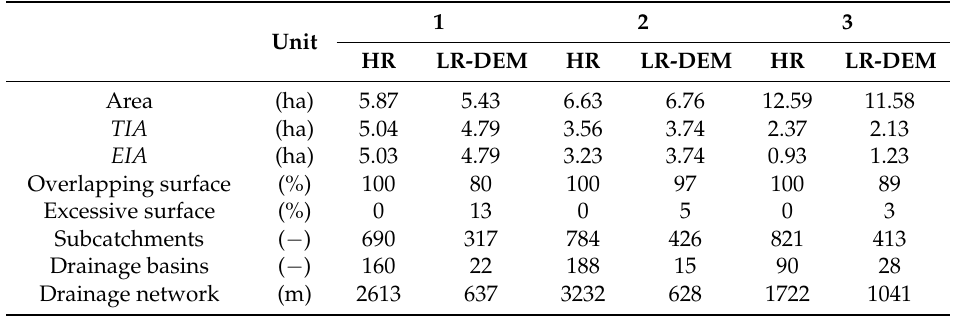
Table 5. Catchment properties of the HR and LR-DEM models of the three study catchments and the overlapping and excessive surface